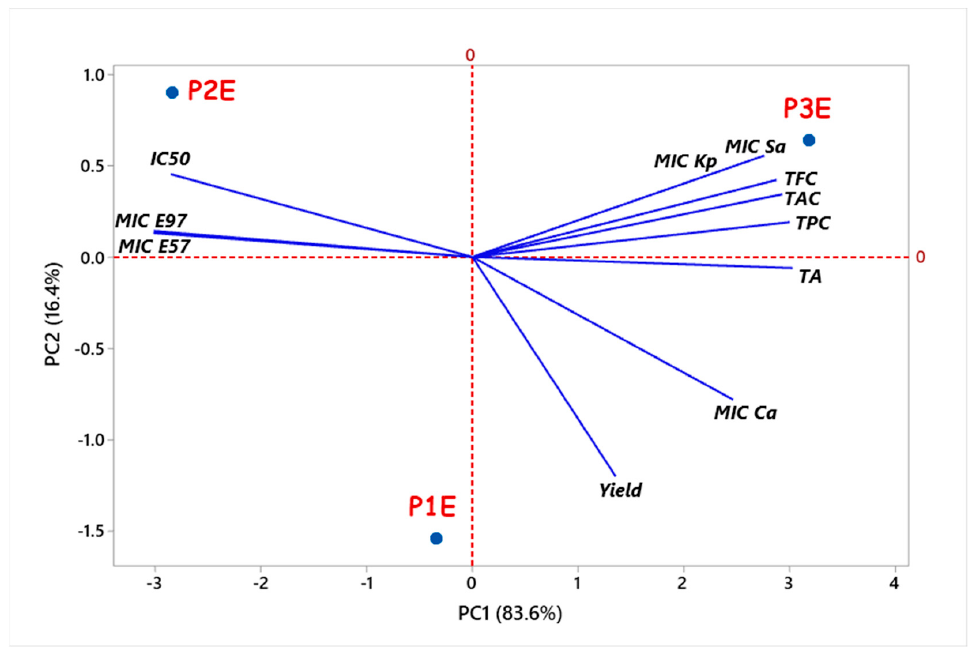
Figure 6. Biplot overlays the score plot and the loading plot. MIC: minimal inhibitory concentration;